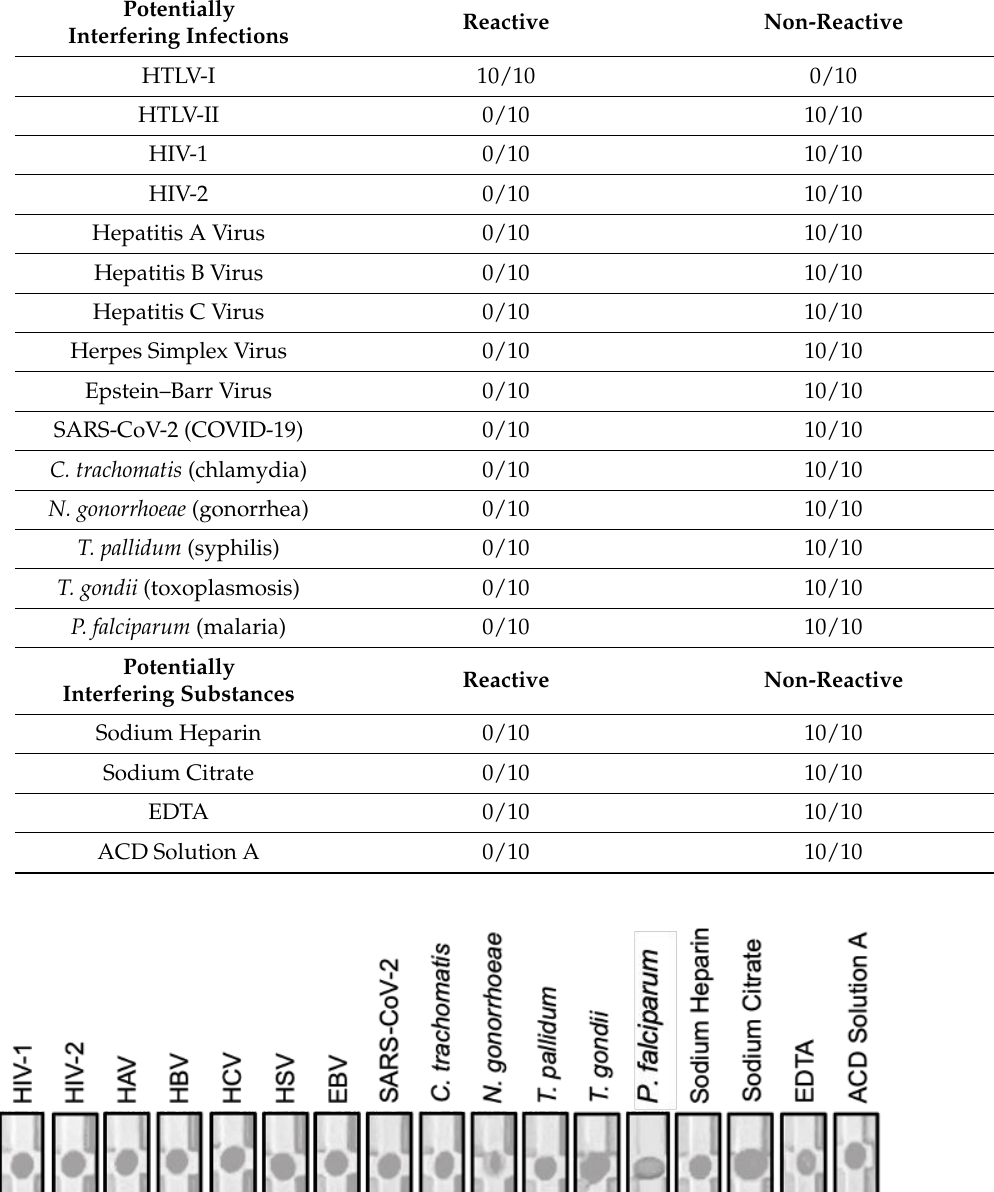
Table 3. Cross-reaction studies with potentially interfering infections and substances.